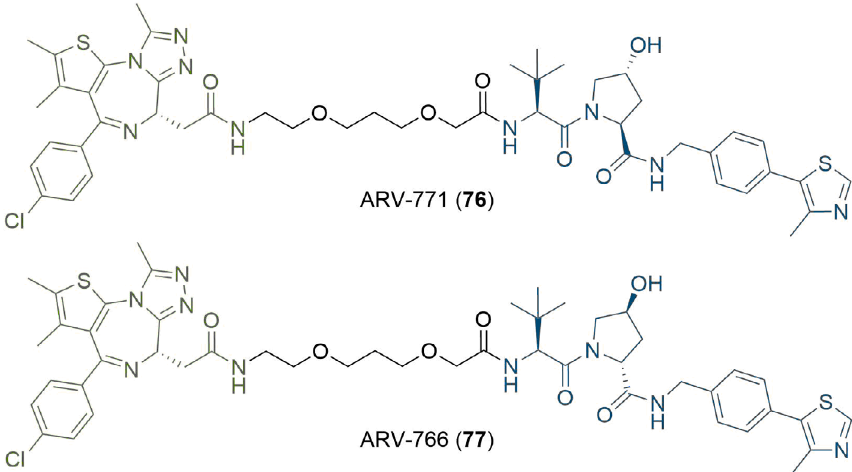
Figure 14. Structures of potent BET degrader ARV-771 (76) and its inactive epimer ARV-766 (77)